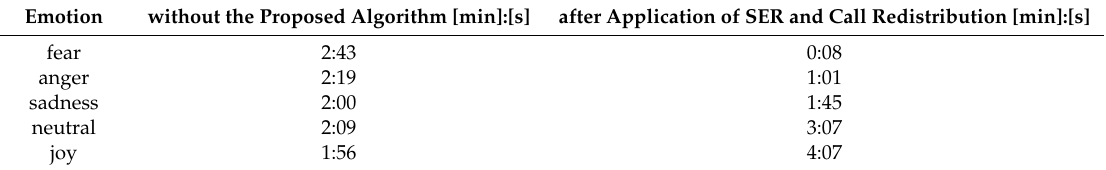
Table 2. Average waiting time when 3 calls are received simultaneously while all operators are busy.